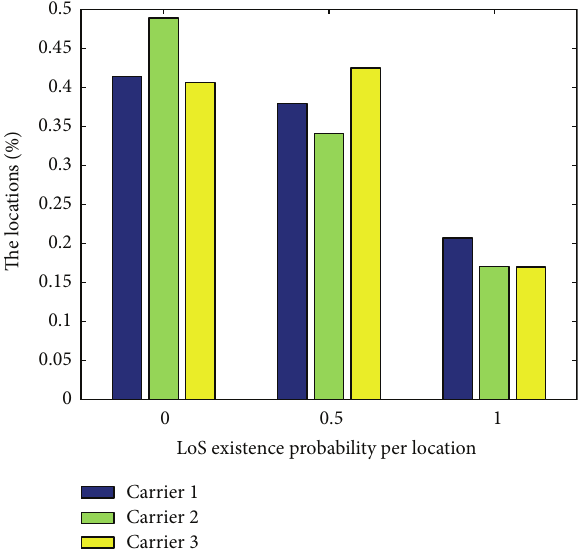
Figure 13: The empirical percentage of LoS existence probability per location.